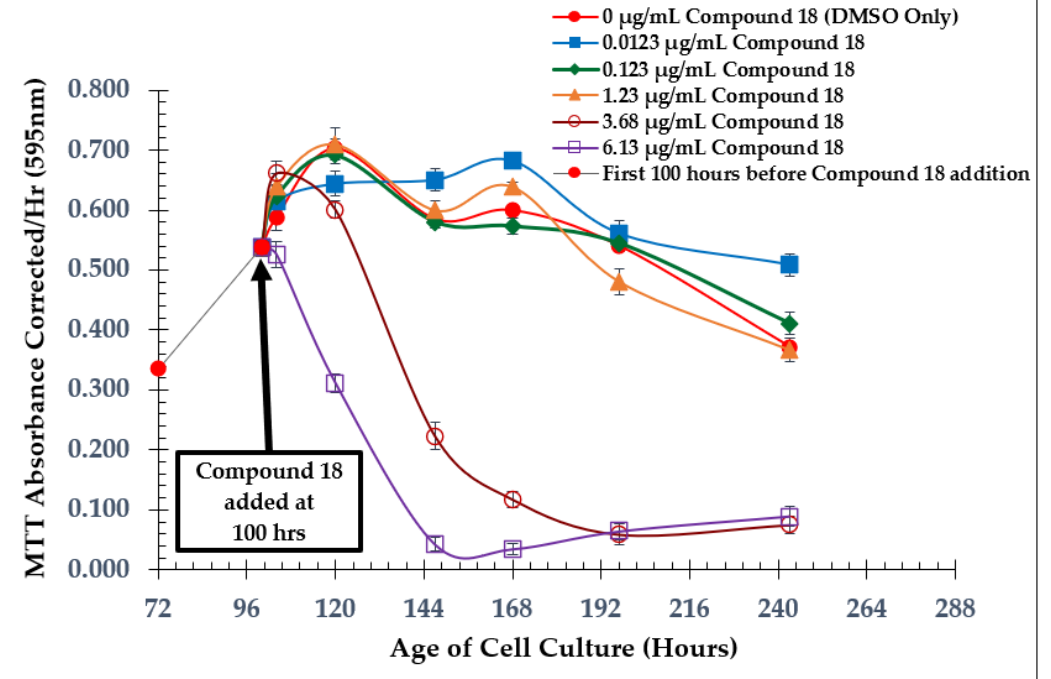
Figure 8. Dose-Dependent Effect of Compound 18 on L. tarentolae— Addition at 100 h; Values are the mean and standard deviation for n = 4 replicates.